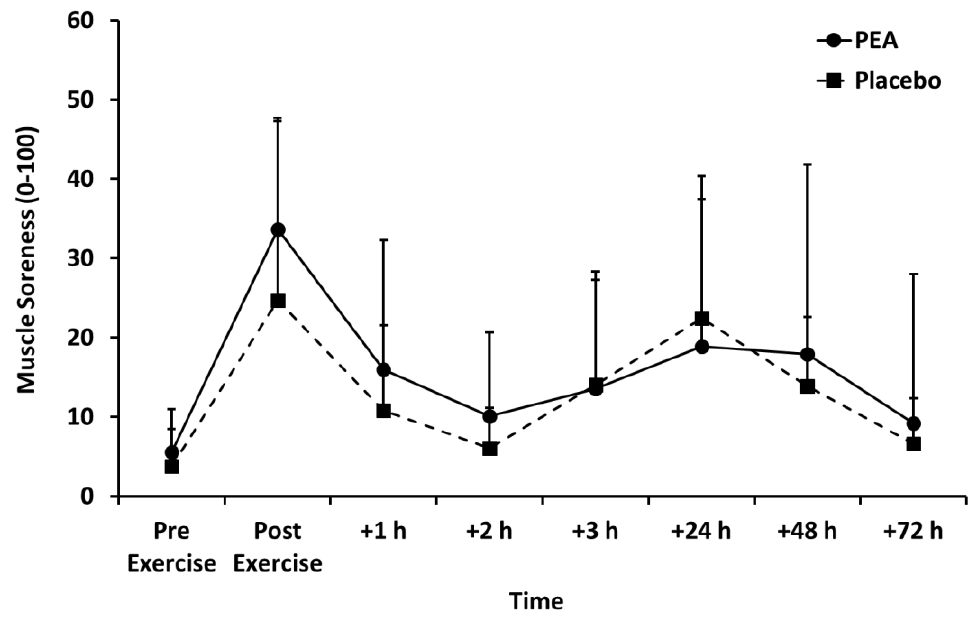
Figure 3. Muscle soreness for palmitoylethanolamide (PEA) and placebo groups. Values are mean ± SD.